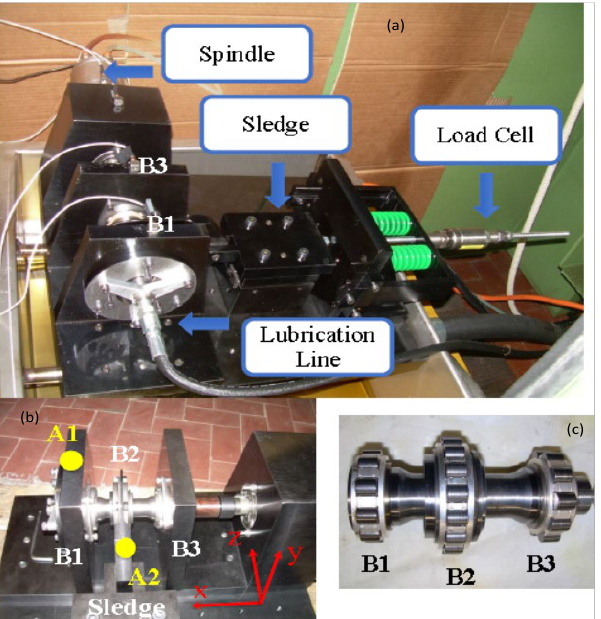
Figure 7. The experimental test rig: ( a ) general view of the test rig; ( b ) positions of the two accelerometers and the reference coordinate system; ( c ) the shaft with its three roller bearings [24].